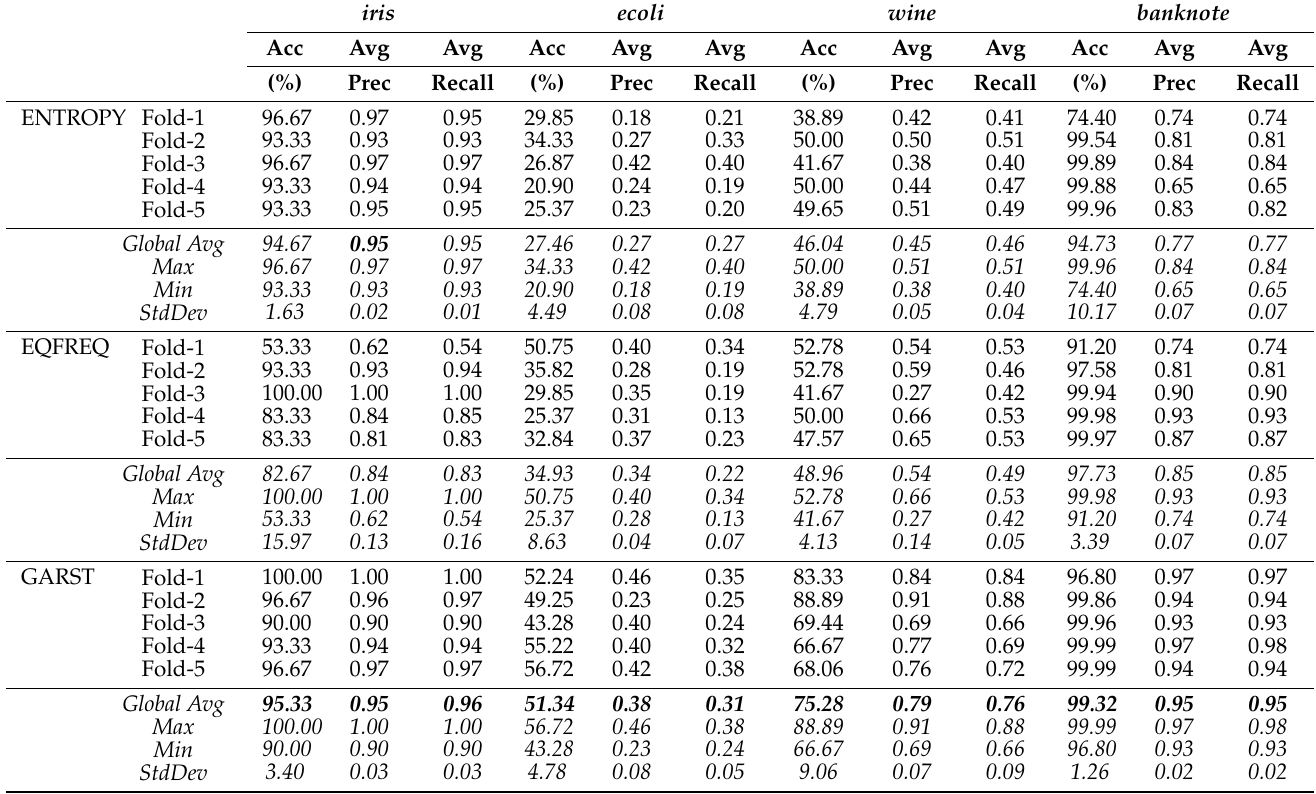
Table 4. The accuracy , precision , and recall of each method.